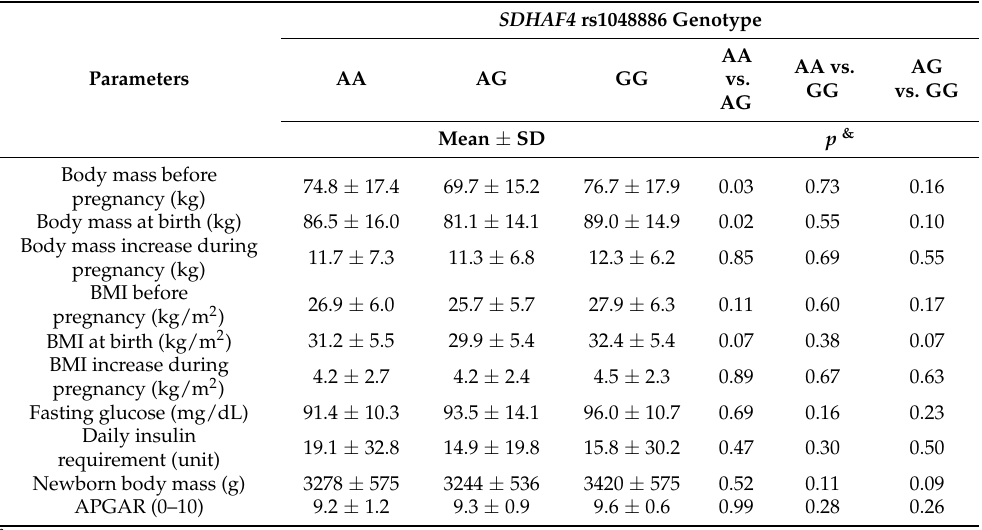
Table 3. Clinical parameters of women with GDM stratified according to SDHAF4 rs1048886 genotype